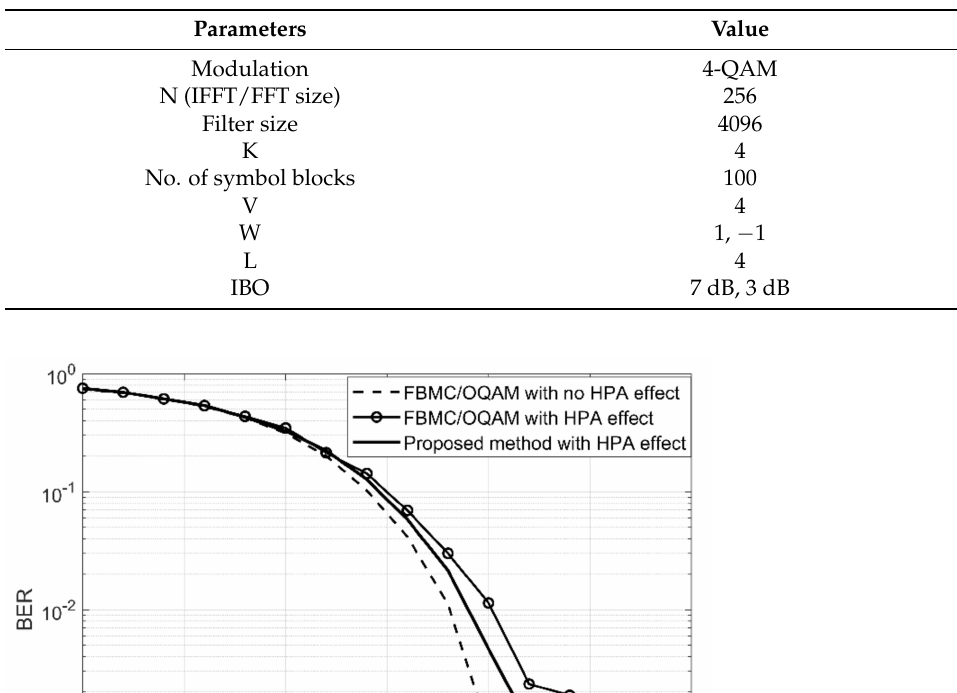
Table 4. Simulation parameters for BER (bit-error-rate) calculations.